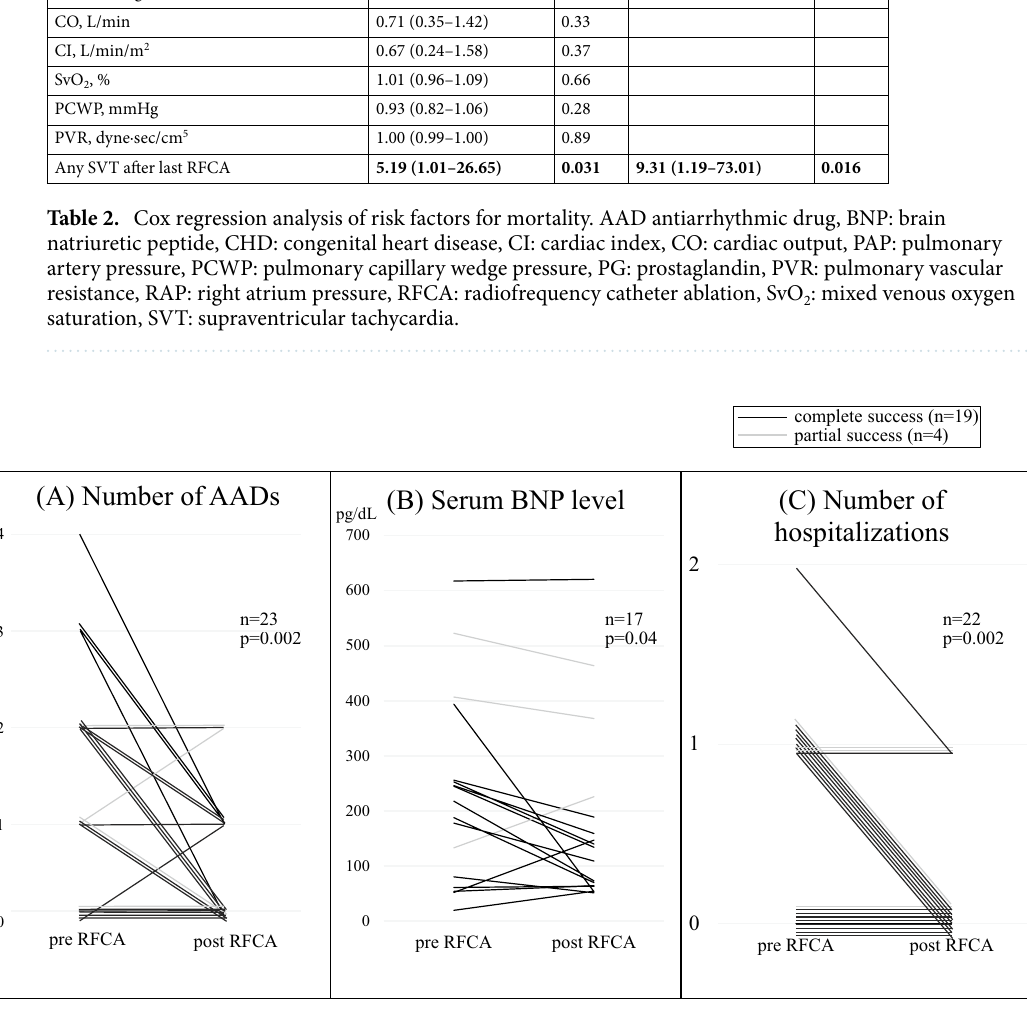
Figure 3. Acute success rate of radiofrequency catheter ablation for supraventricular tachycardia. AFL: atrial flutter, AT: atrial tachycardia, AVNRT: atrioventricular nodal reentrant tachycardia, FAT: focal atrial tachycardia, IART: intra-atrial reentrant tachycardia, ns: